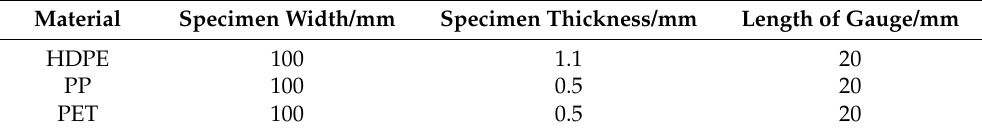
Table 1. Parameters of geocell strips.